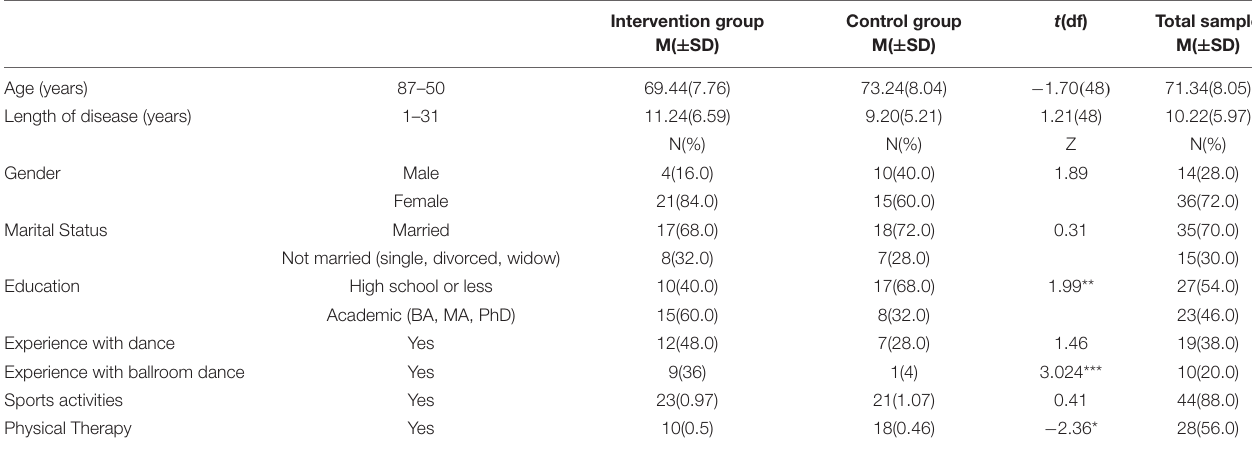
TABLE 1 | Descriptive and demographic characteristics of the study